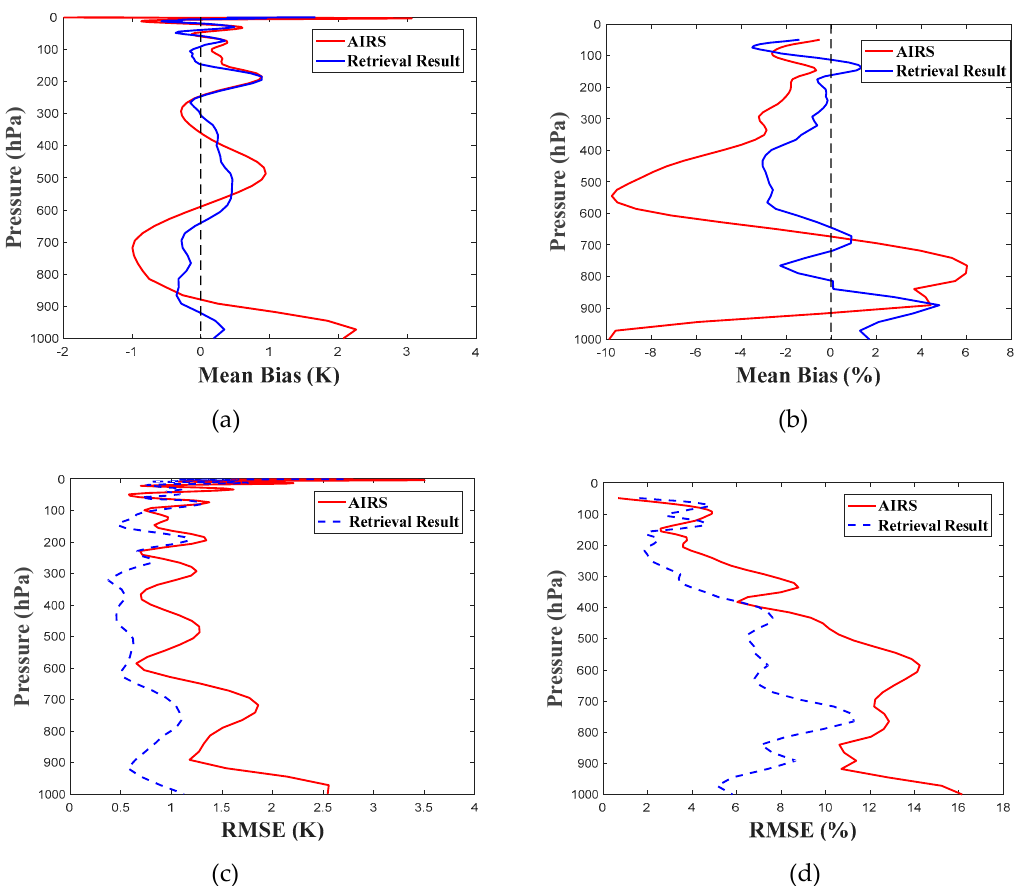
Figure 13. ( a , b ) The MB and RMSE of the temperature profile, respectively. ( c , d ) are the MB and RMSE of the humidity profile, respectively. The red solid line represents the comparison between the AIRS products and the ERA-Interim data, while the blue dotted line represents the comparison between retrieval profiles and the ERA-Interim data.